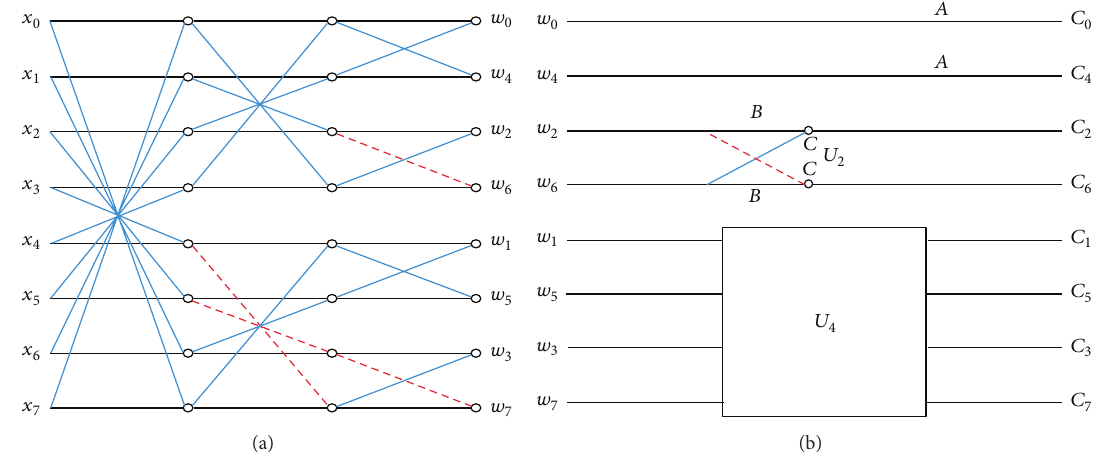
Figure 1: ((a), (b)) The signal flow graph of fast integer DCT using indirect method.